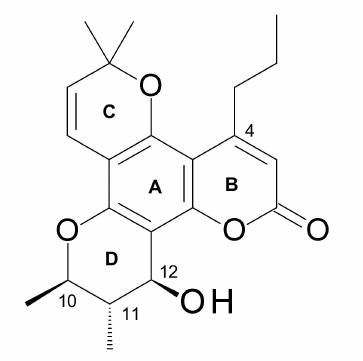
Figure 1. Rings A, B, C and D, and carbon numbering in ( + )-calanolide A ( 1